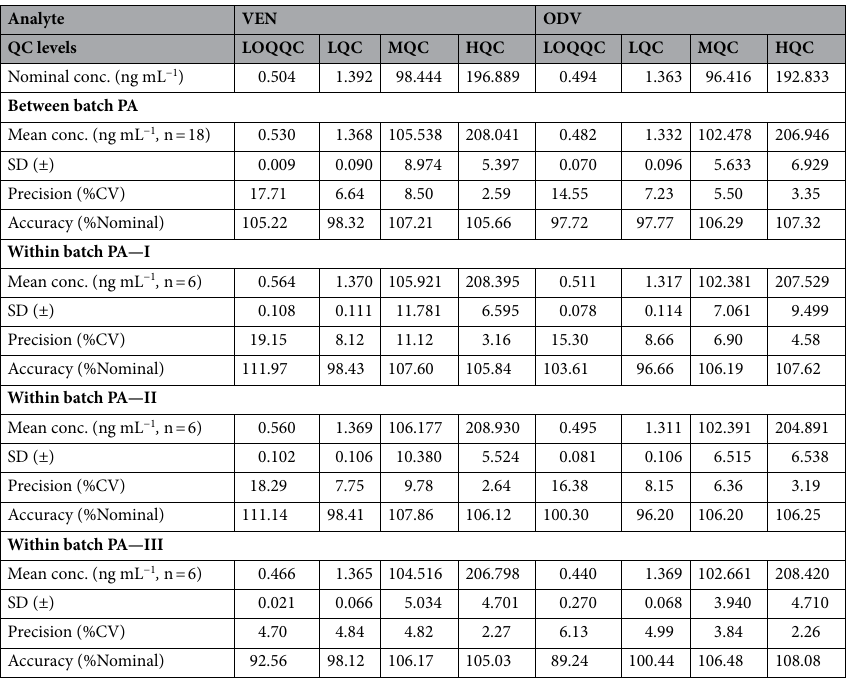
Table 8. Between batch and within batch PA results for four QC levels of each analyte in rabbit